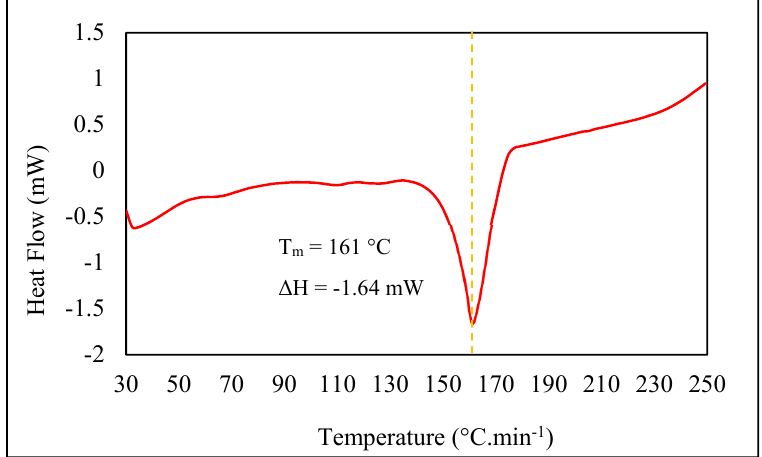
Figure 7. Thermogram curve as DSC result.